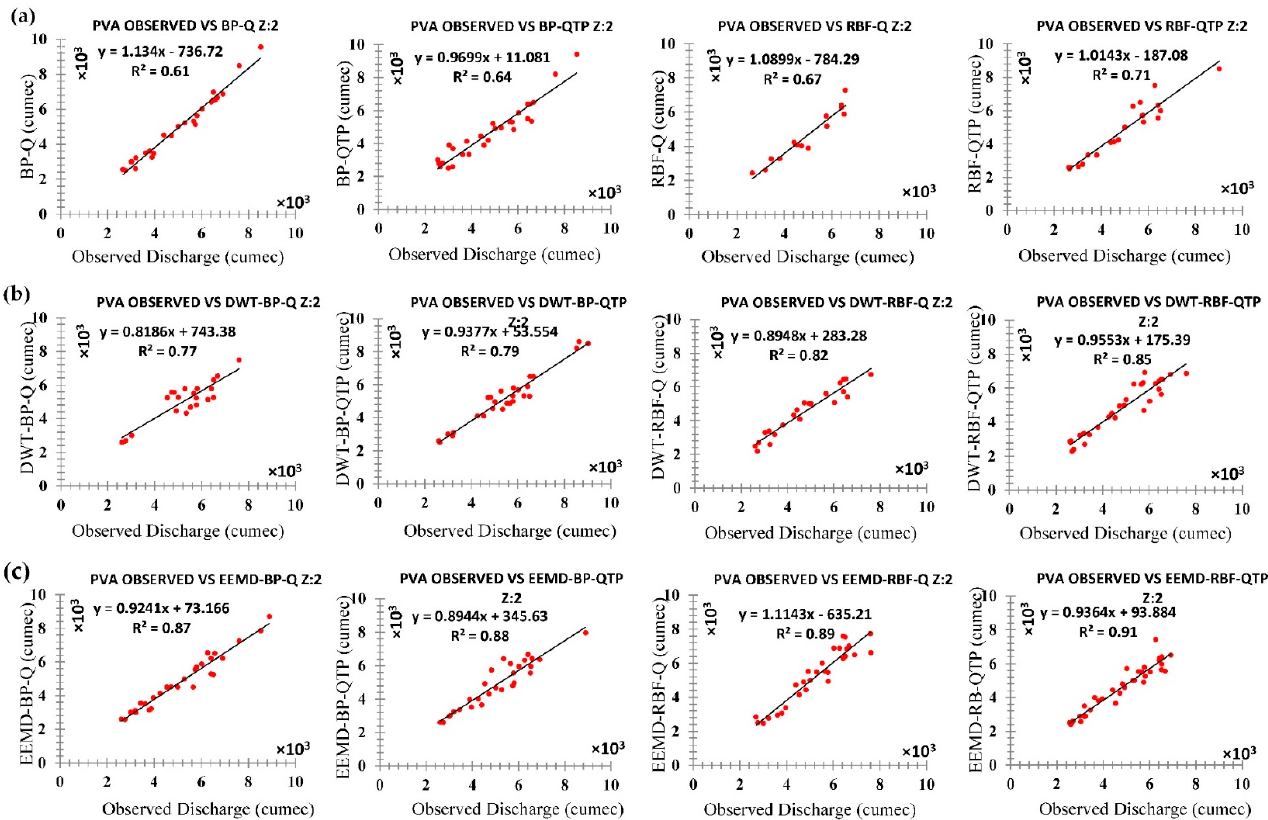
Figure 18. Monthly streamflow estimations for peak values in the flood season Zone Two ( a ) OBS VS ANN (Q & QTP) Inputs, ( b ) OBS VS ANN-DWT (Q & QTP) Inputs, and ( c ) OBS VS ANN-EEMD (Q & QTP) Inputs.